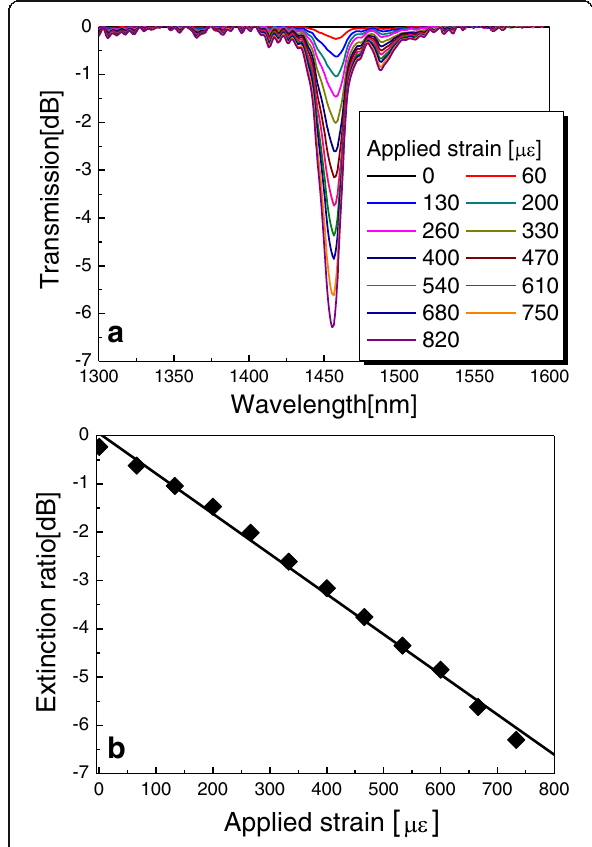
Fig. 4 a Transmission spectra of the proposed PCF-based LPG with variations in strain. b Variation of extinction ratio as a function of strain